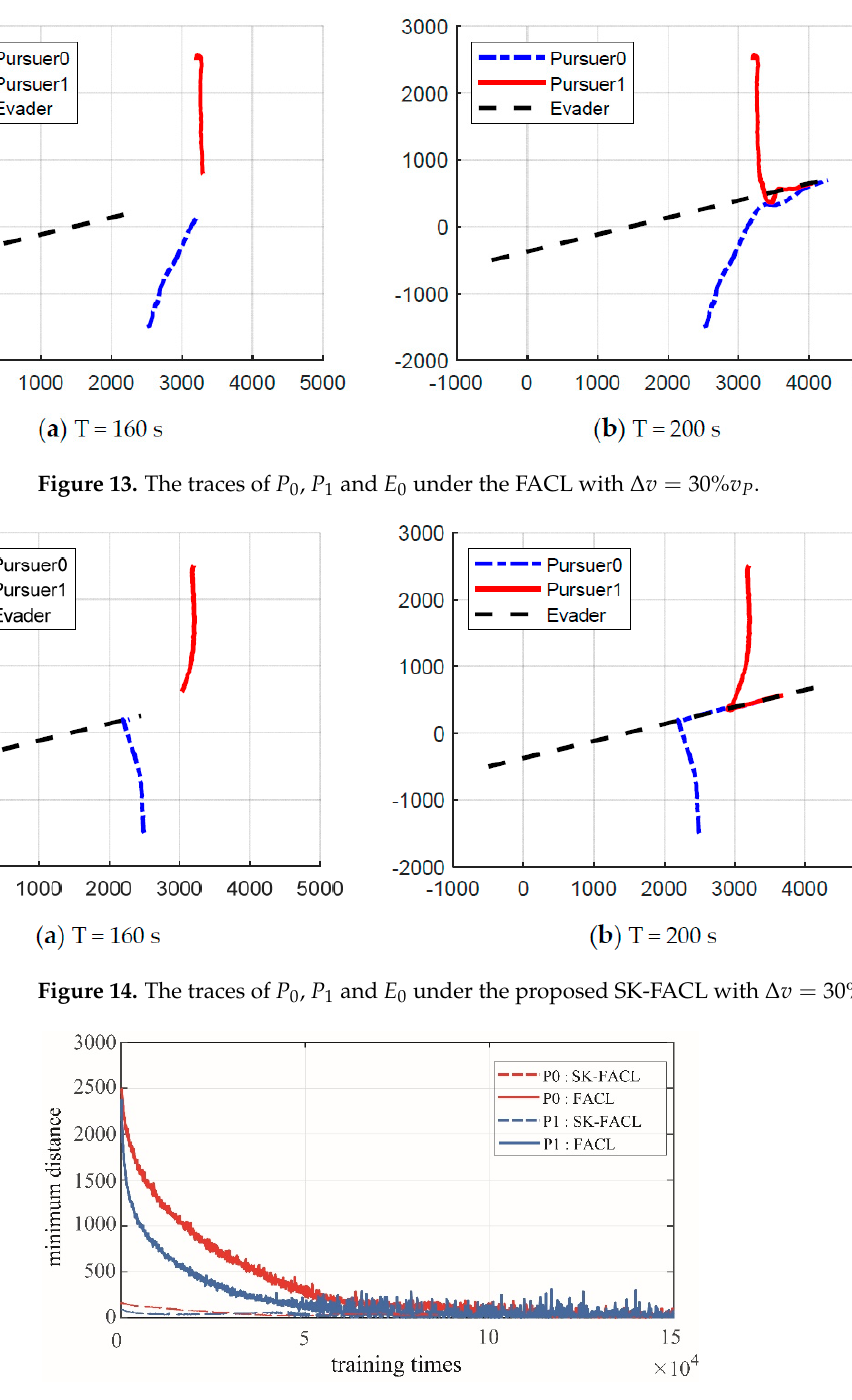
Figure 15. The minimum distances between P0, P1 and E0 along with the training times under the SK-FACL and FACL.